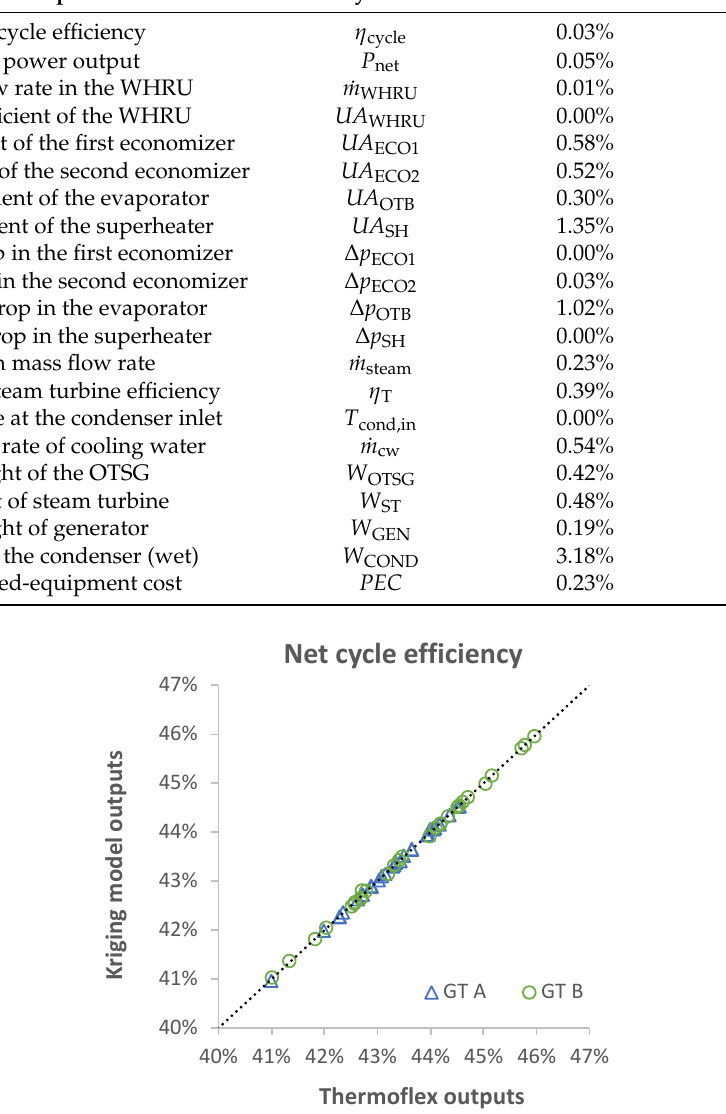
Figure A2. Parity plot of steam flow rate for Kriging model validation. Figure A3. Parity plot UA coefficient of superheater for Kriging model validation.